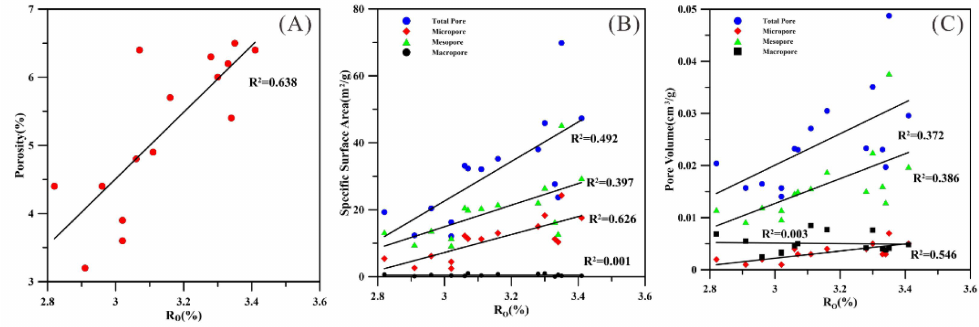
Figure 13. Relationship between pore structure and Ro in Wufeng–Longmaxi Fm of